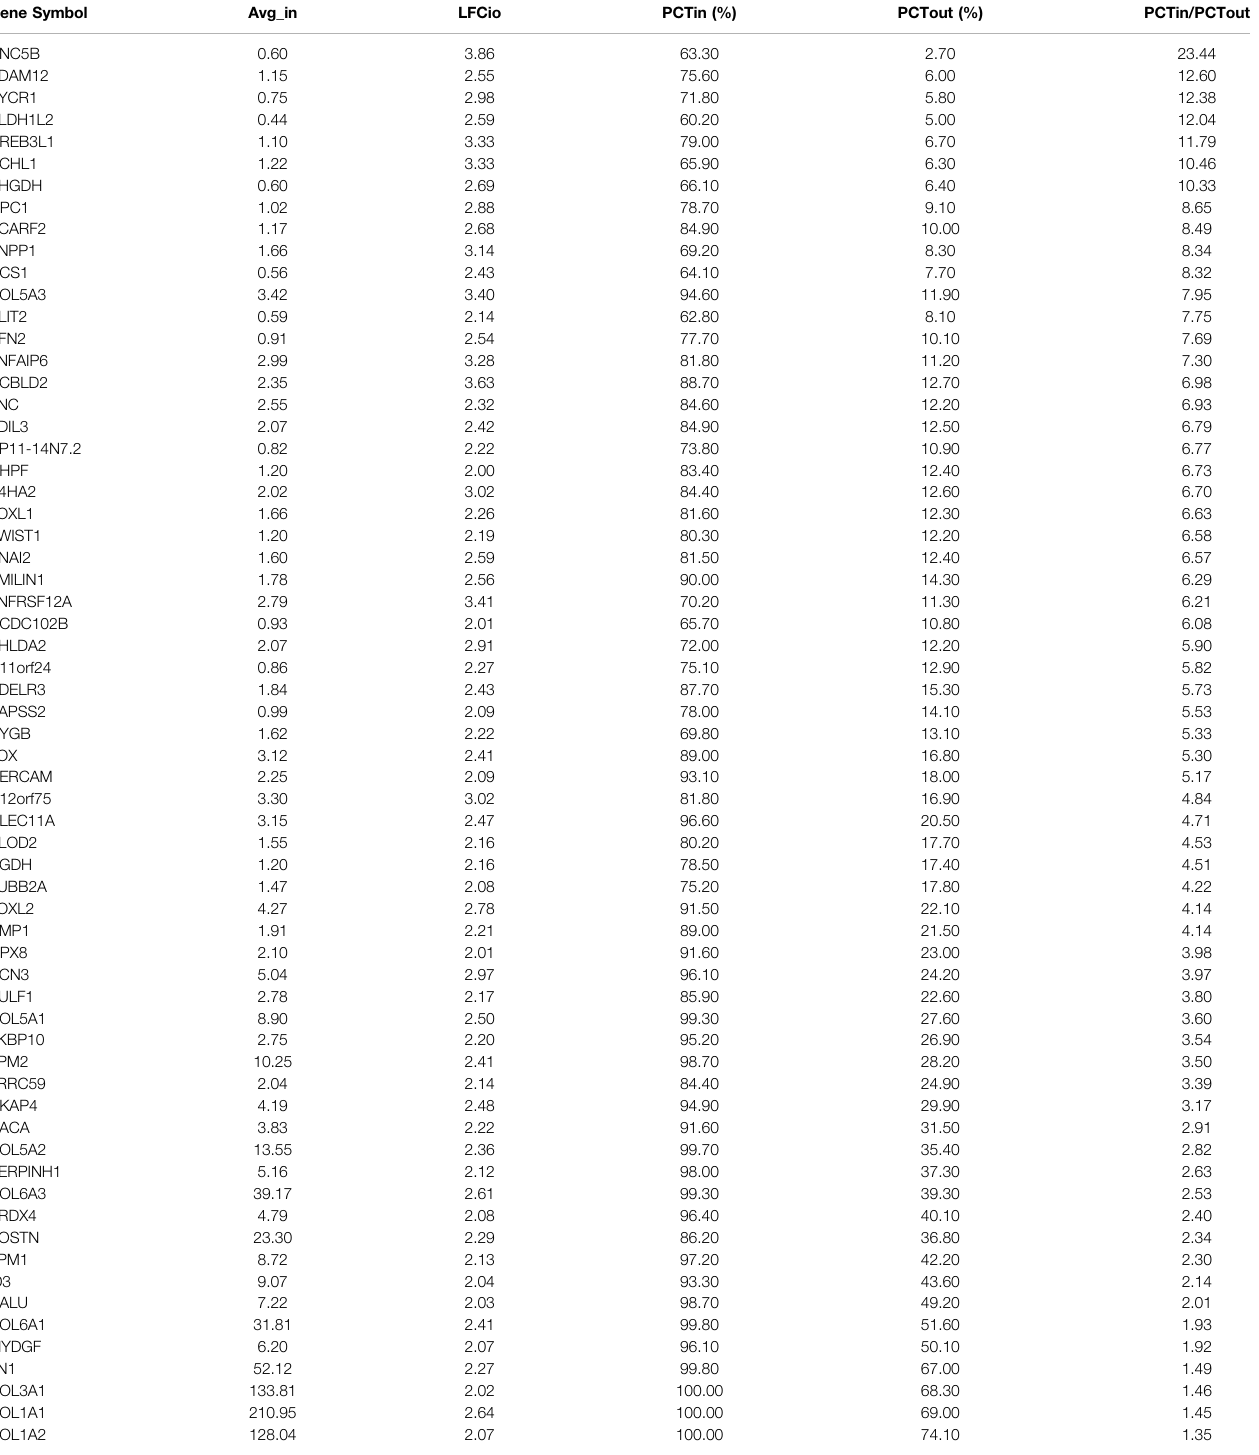
TABLE 2 | The gene-expression signature of mesenchymal stem cells. Gene